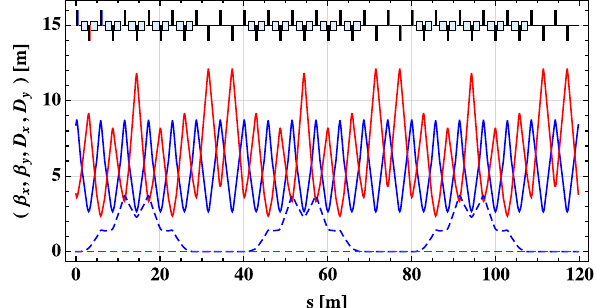
FIG. 2. RCS lattice and optics as proposed in the feasibility study [12].